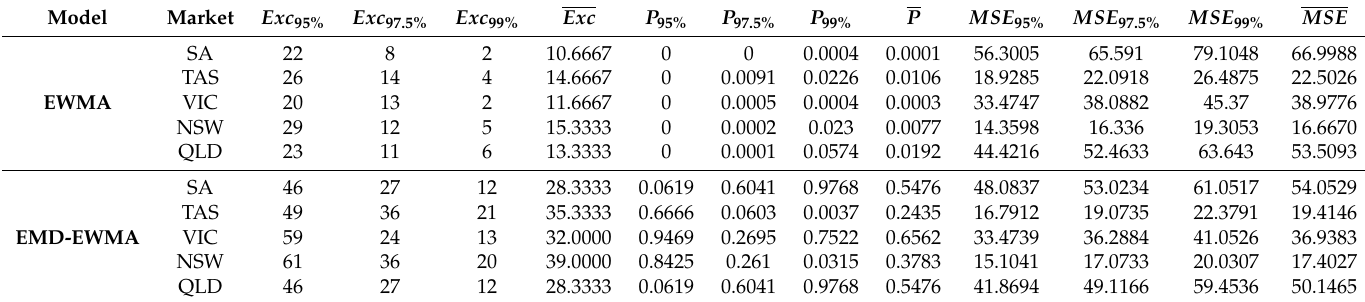
Table 3. Out-of-sample exceedances of different models under Student’s t